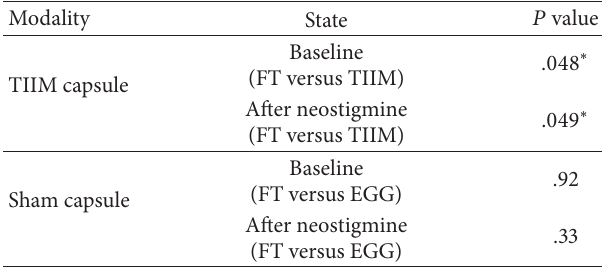
Table 3: Statistical comparison between the dominant frequency peaks of the FT and TIIM/EGG recordings using paired Student’s 𝑡 -test. Modality State 𝑃 value TIIM